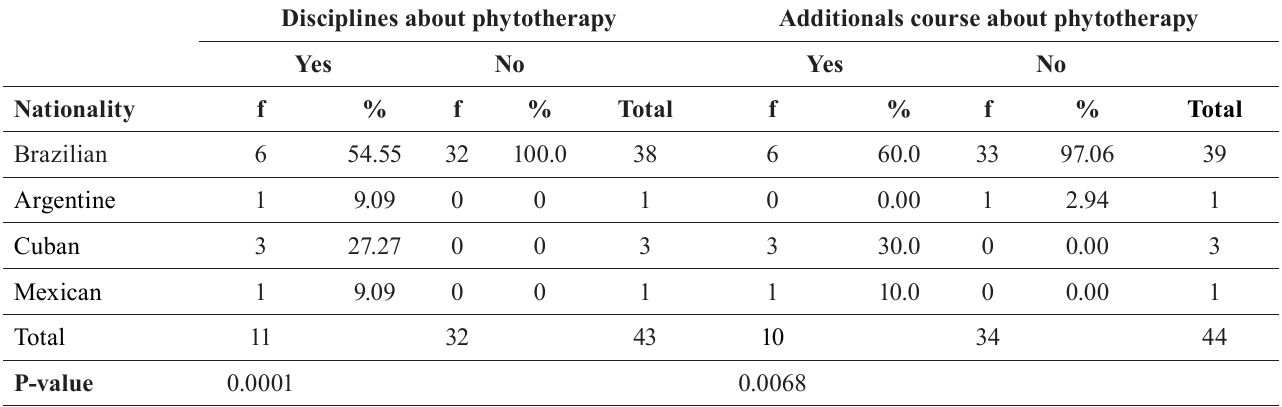
TABLE III – Nationality of the interviewed doctors and the realization of disciplines and courses about phytotherapy Disciplines about